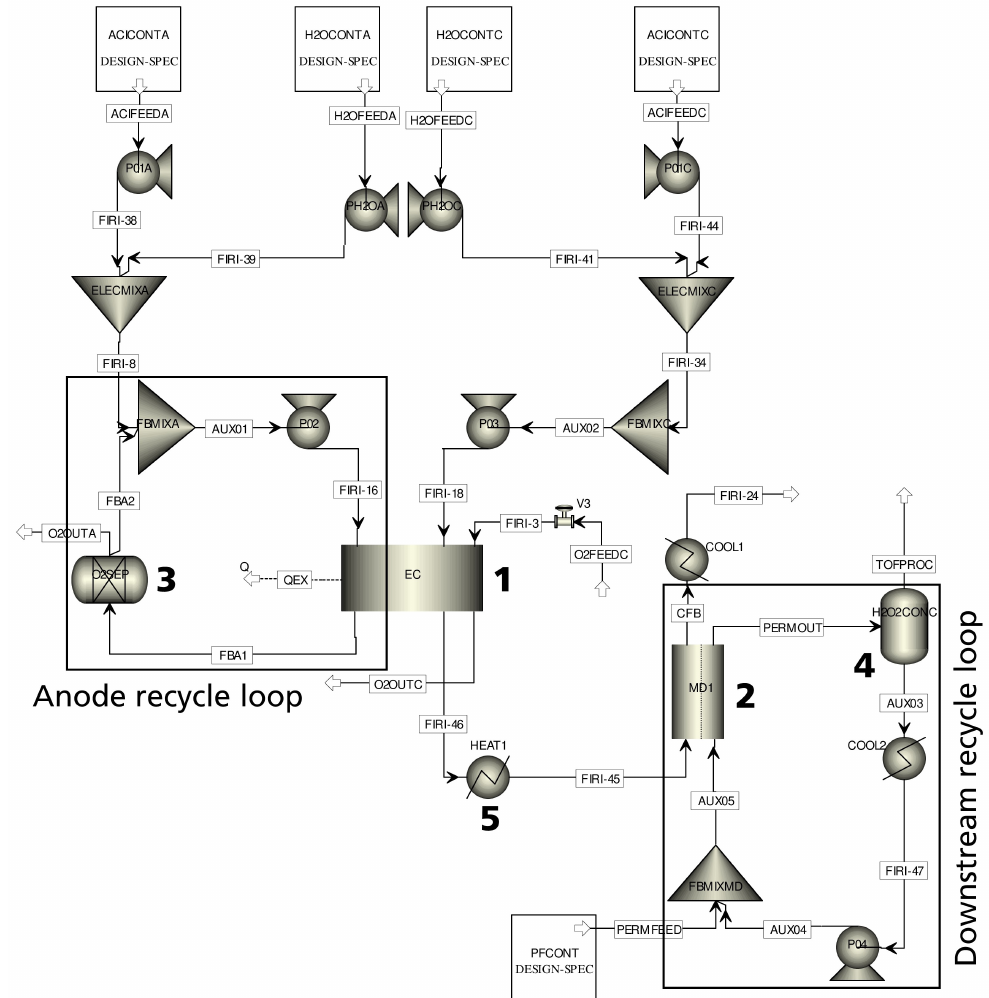
Figure 4. Flowsheet of the process for H 2 O 2 production with two recycle loops (one for the anode half cell and one in the downstream processing) and five design specifications as taken from Aspen Plus ® . The most important unit operations are marked with bold numbers: 1. Electrochemical reactor EC for H 2 O 2 production, 2. Membrane distillation module MD1 for acid separation, 3. Oxygen separation O2SEP for removal of O 2 from the anode recycle loop, 4. Flash H2O2CONC for product concentration, 5. Heater HEAT1 for thermal gradient across the membrane unit. The product is drained from the process in the main outlet